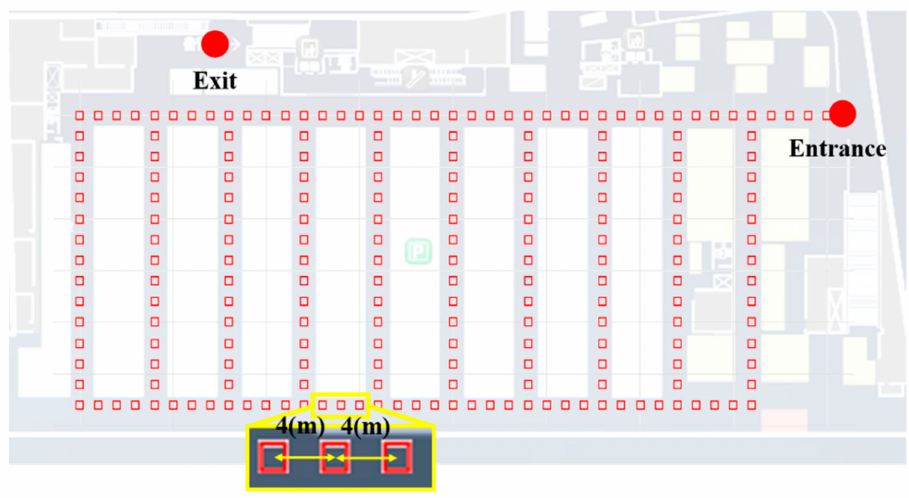
Figure 3. Reference points definition in underground parking